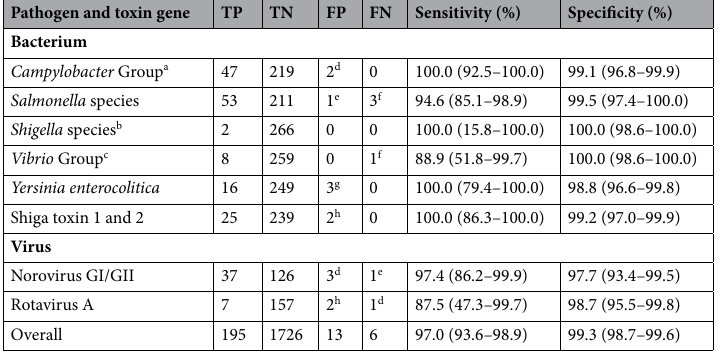
Table 1. Efficiency of the Verigene Enteric Pathogens Nucleic Acid Test to detect pathogens and toxin genes for clinical stool samples. Data were compared to reference methods and expressed as numbers or percentages (95% confidence interval). TP true positive, TN true negative, FP false positive, FN false negative. a Campylobacter jejuni , coli , and lari. b Shigella boydii , sonnei , flexneri , and dysenteriae. c Vibrio cholerae and parahaemolyticus. d All samples were positive in the discrepant analysis. e The sample was negative in the discrepant analysis. f All samples were positive in re-examination using the Verigene EP test. g One sample was positive and two samples were negative in the discrepant analysis. h One sample was positive and the other was negative in the discrepant analysis.